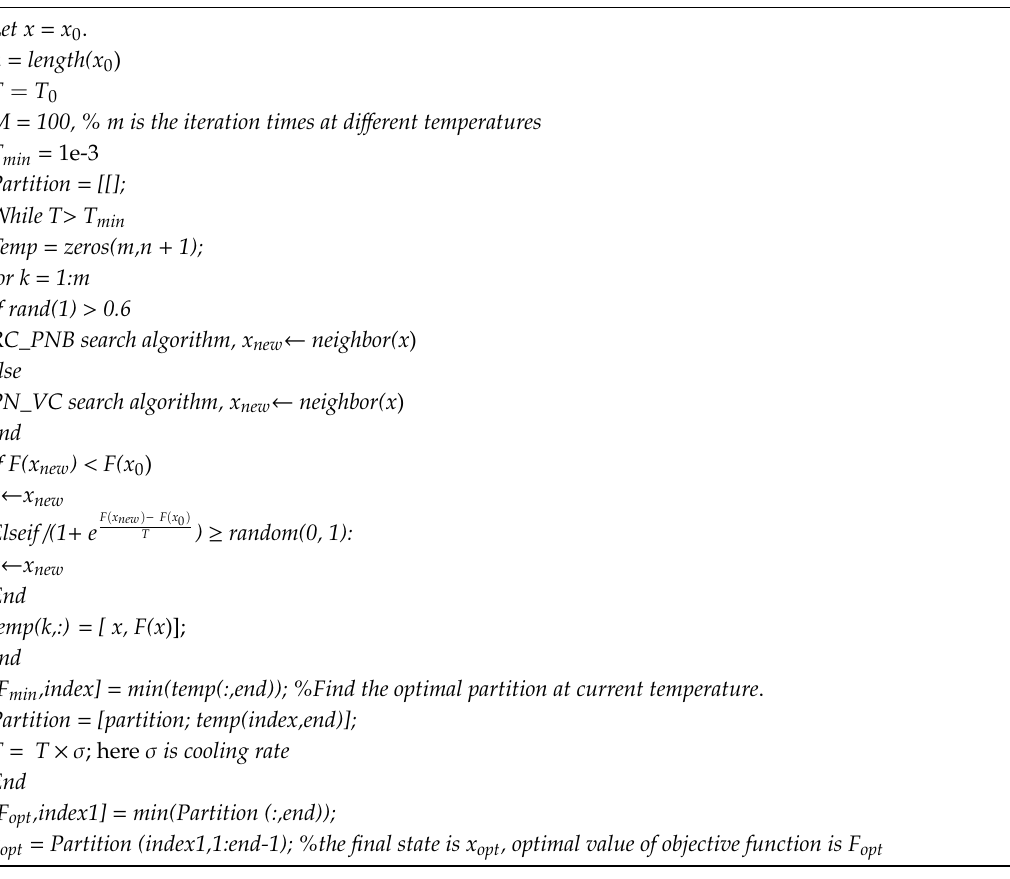
Algorithm 3 Simulated Annealing